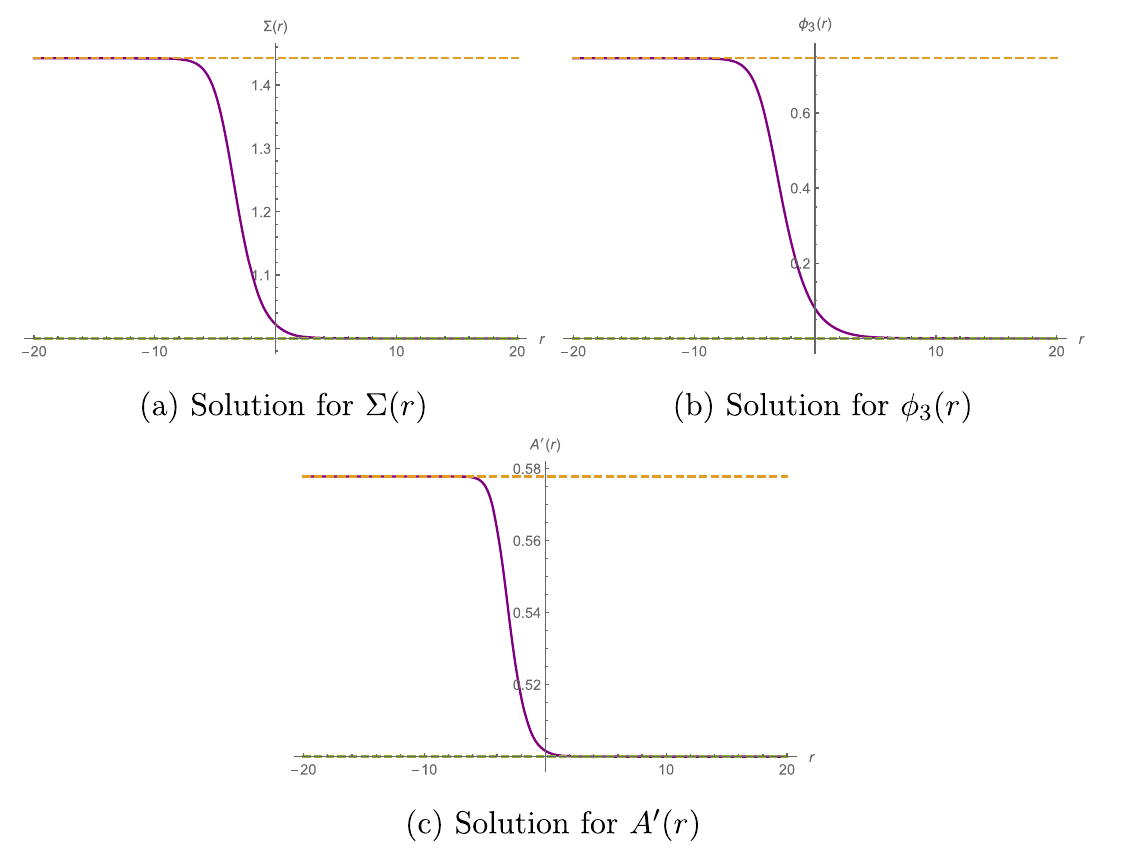
Fig. 3 An RG flow from N = 4 AdS 5 critical point with SO ( 2 ) D × SO ( 3 ) × SO ( 3 ) symmetry to N = 2 AdS 5 fixed point with SO ( 2 ) diag × SO ( 3 ) . In this case, φ 1 = φ 2 = 0 along the symmetry in the IR with g = 1, ρ = 3 and ζ = 1 2